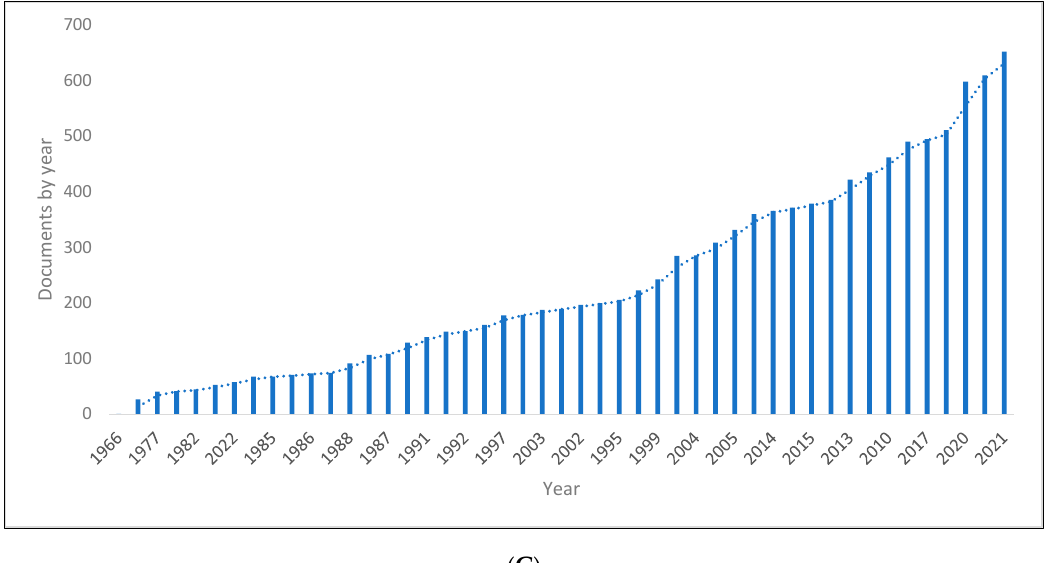
Figure 1. Pragmatics knowledge production size by year. ( A ) (Scopus). ( B ) (WOS). ( C ) (Lens).